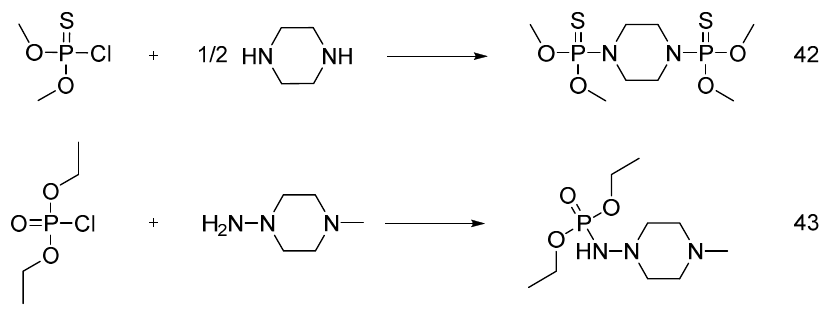
Figure 27. Synthesis of ( 42 ) and ( 43 ).